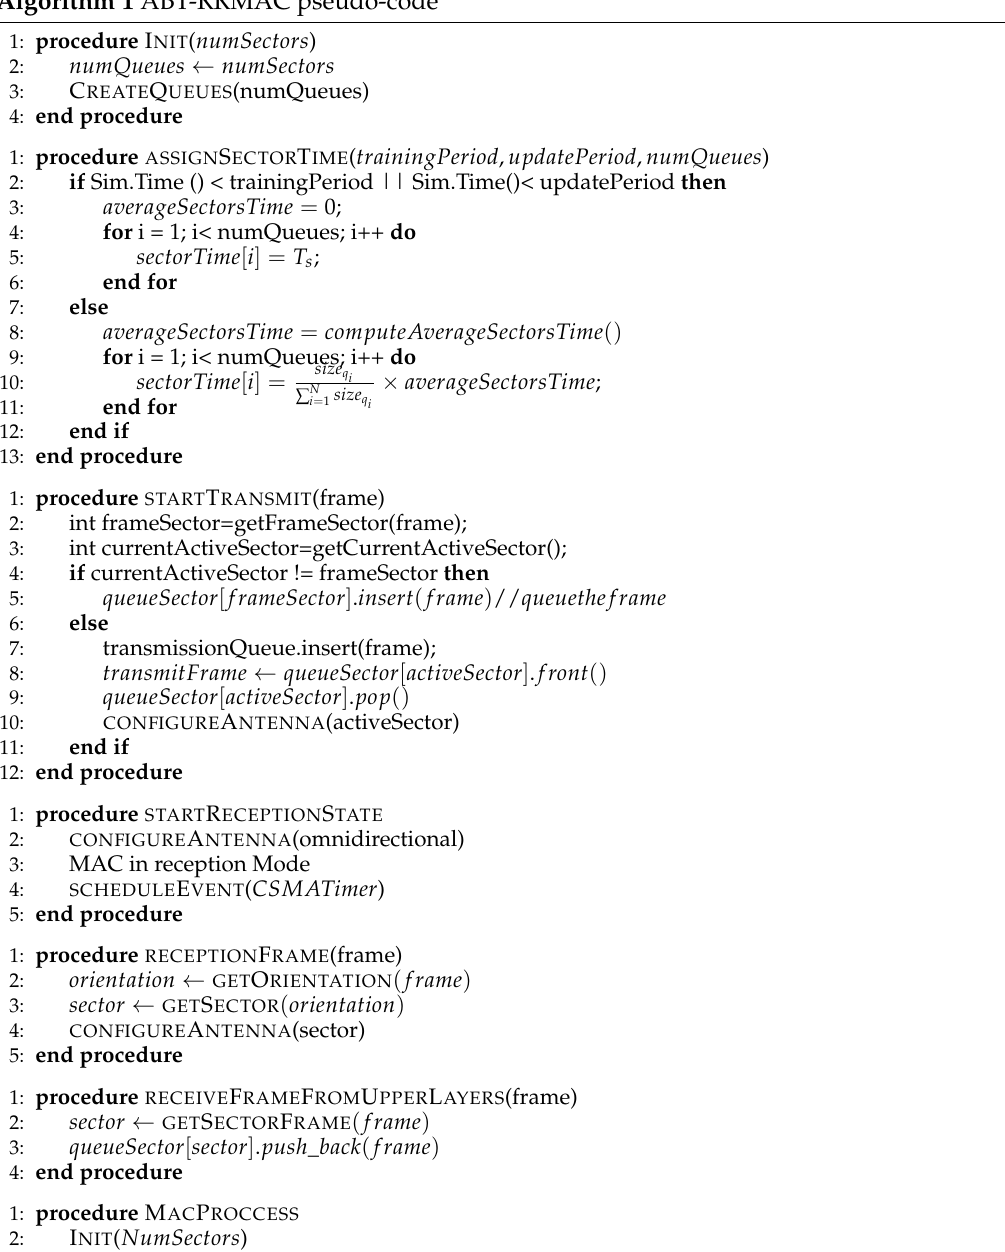
Algorithm 1 ABT-RRMAC